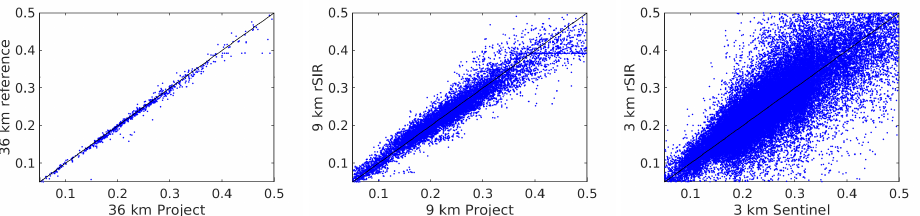
Figure 7. Scatter plots of estimated soil moisture in cm 3 cm − 3 versus validated soil moisture products for day 300 in 2016 from South Sudan at (from left to right ) 36 km, 9 km, and 3 km where the 36 km and 9 km are SMAP project products and the 3 km product is the SMAP-Sentinel merged product.